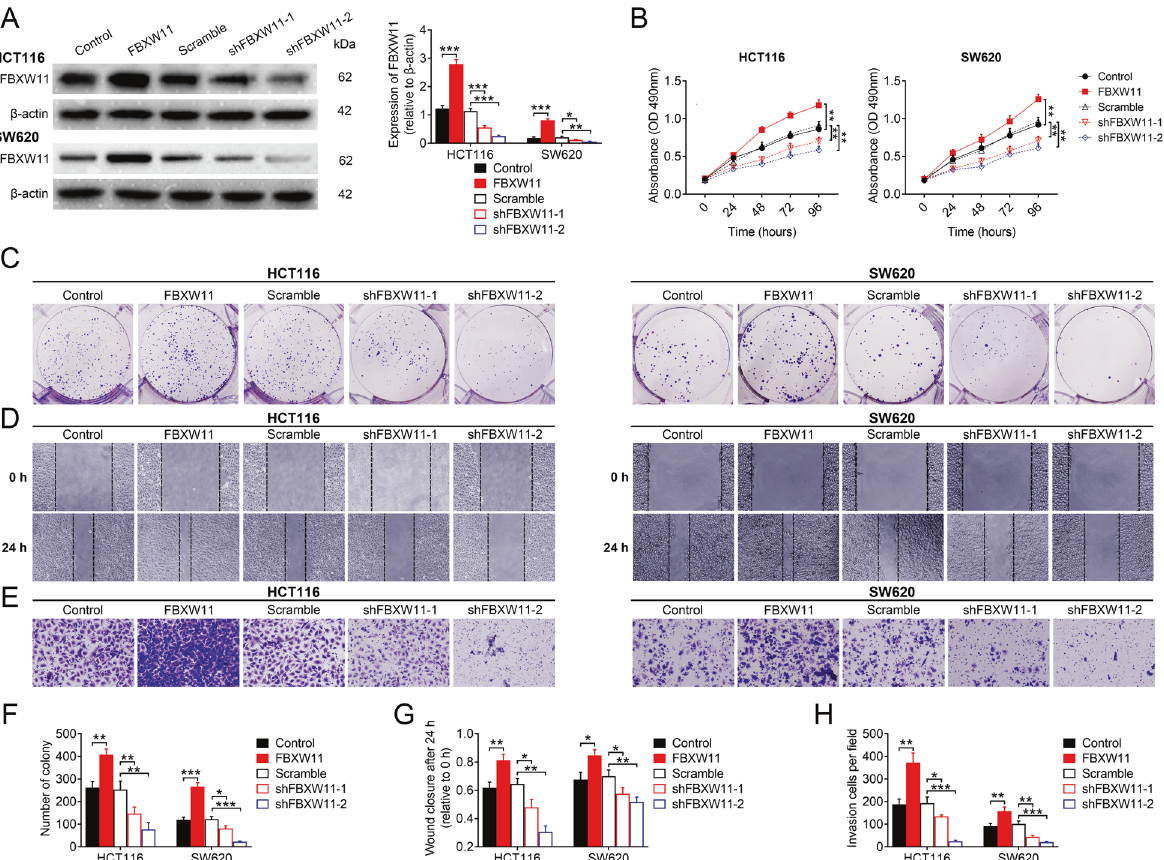
Fig. 2 Effect of FBXW11 on the growth and migration of CRC cells. Human CRC cell lines HCT116 and SW620 were transfected with recombinant lentiviral vectors carrying FBXW11 or shRNAs targeting FBXW11 (shFBXW11-1 and shFBXW11-2). The control groups